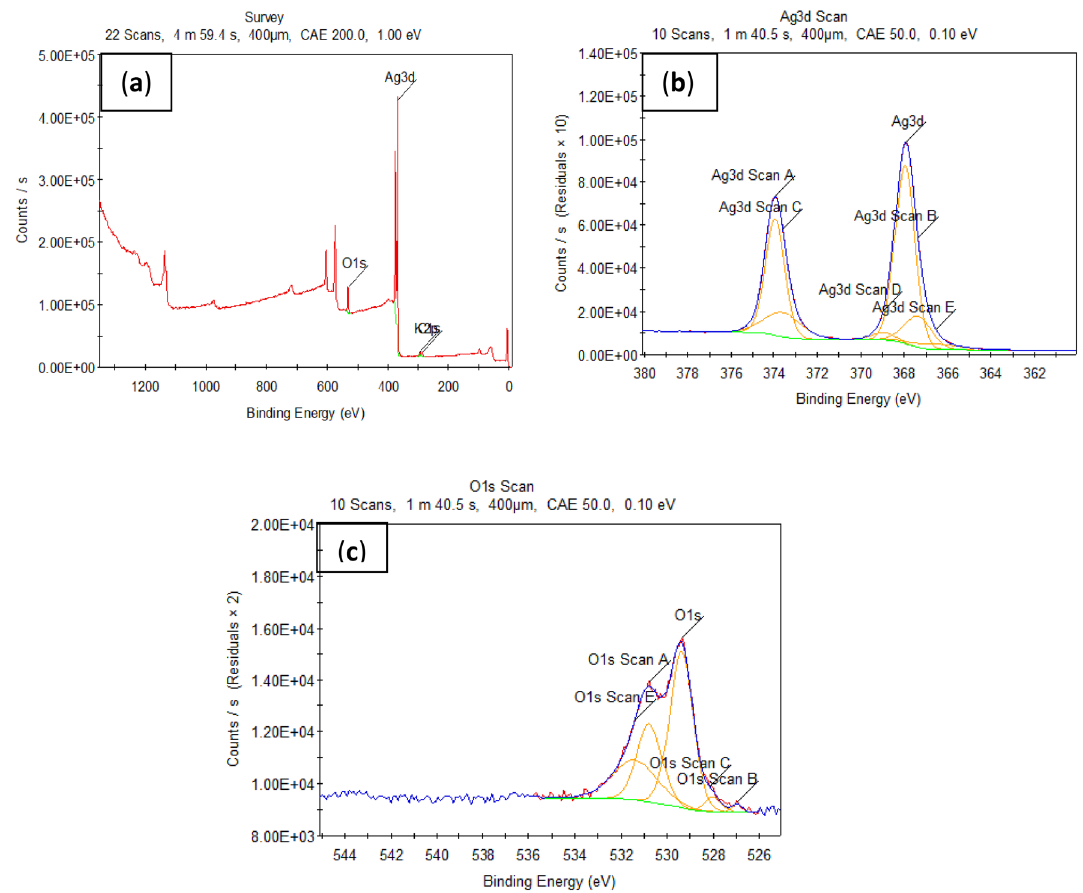
Figure 3. XPS analyses of the Ag@Ag 2 O NCs; ( a ) Survey, ( b ) Ag3 d and ( c ) O1 s